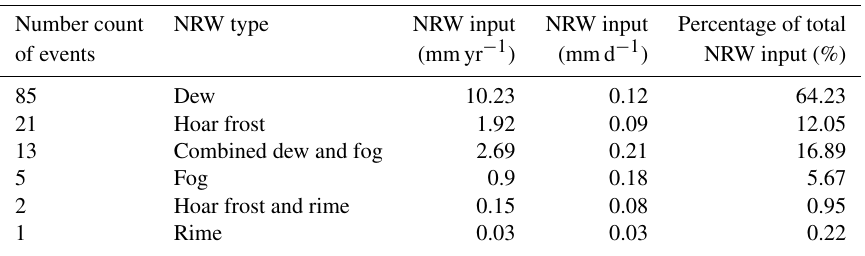
Figure 7. (a) Comparison of WFPS (based on soil moisture measured at 15cm depth) inside the ML pots vs. the control from the beginning of May till the middle of October 2019 at CH-FRU. (b) Soil temperature from ML pot 1 at CH-FRU during a non-rainfall period in July (marked with the red box in panel (a) ). (c) Soil temperature deviations of ML pot 1 from the control by hour of day during the same period as marked in panel (a) and used in panel (b) . Table 2. Number counts of events with its associated NRW input by type and percentage of the total NRW input during the observation period of 12 months at